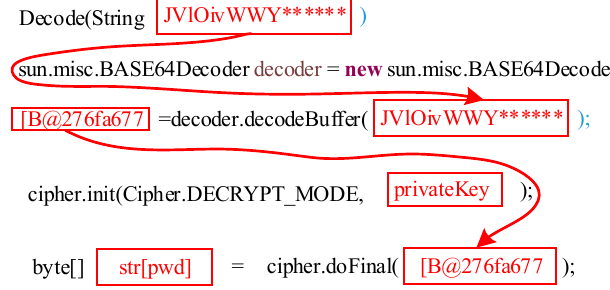
Figure 39. Dependencies of server-side security-related implementations.